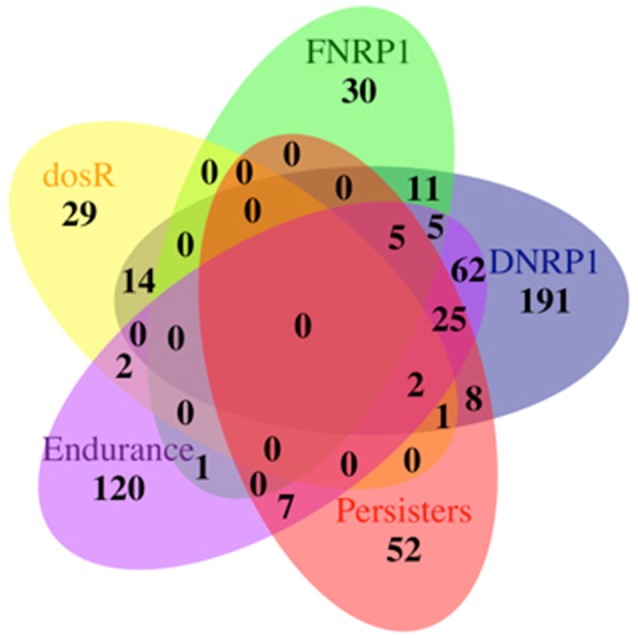
Venn diagram showing the number of statistically significant expressed genes by Mtb grown in conditions including early hypoxia in the presence of dextrose (DNRP1) and long-chain fatty acids (FNRP1); Endurance (EHR) regulon (Rustad et al., 2008), dosR regulon (Voskuil et al., 2004) and persister cells in antibiotics (Keren et al., 2011).